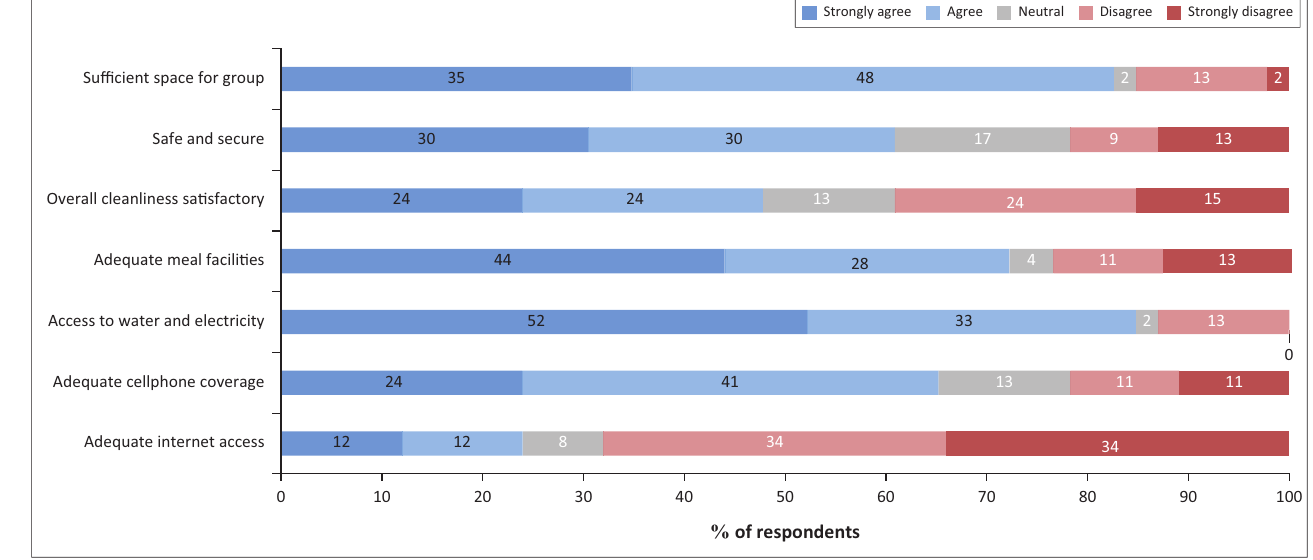
Sufficient space for